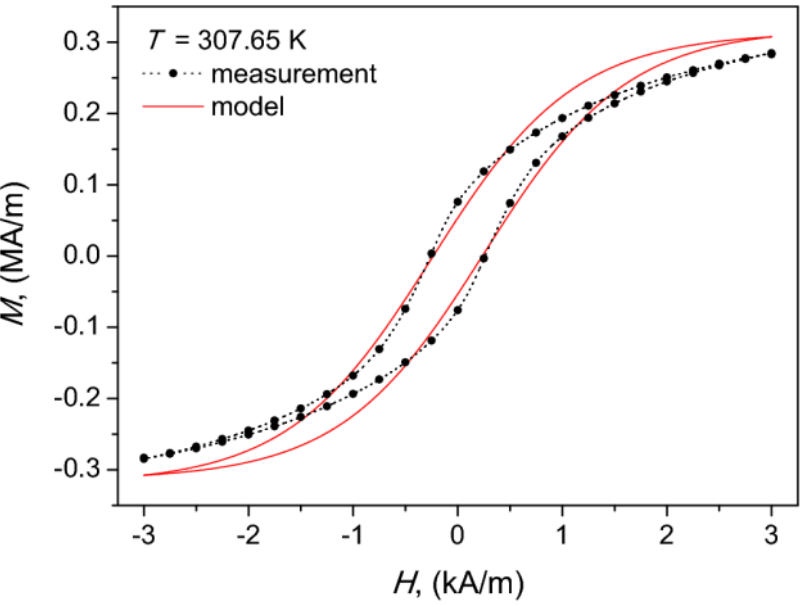
Figure 12. The measured and the modeled hysteresis curve for the composite core at T = 307.65 K.